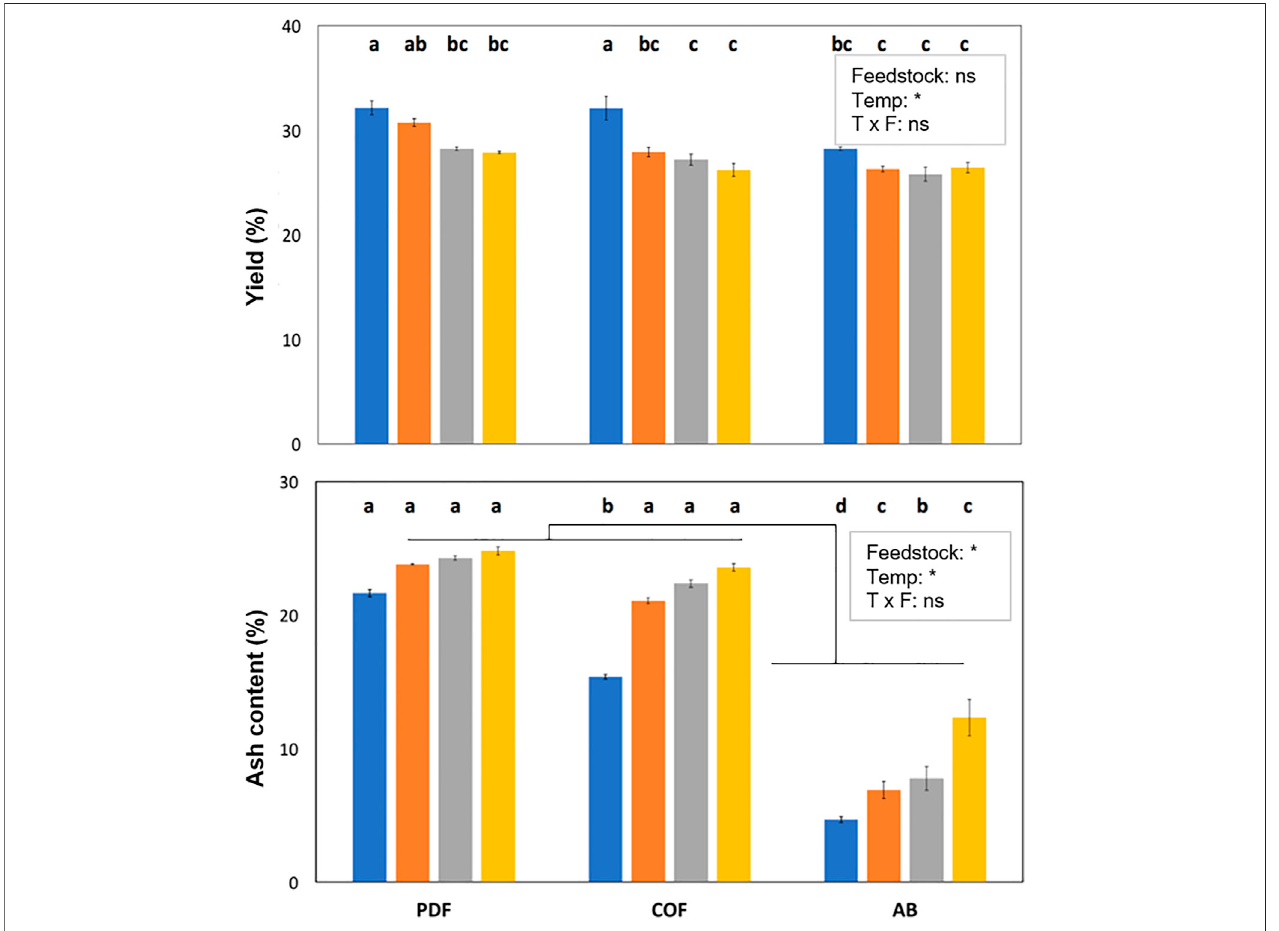
FIGURE4| Yield(%)andashcontent(%)forthe3biochars (PDF,COF, andAB)produced at4temperatures(350,450,500and 550 ° C).Barswithdifferentletters indicate signi fi cant differences p < 0.05, n = 3 (two-way ANOVA, TukeyHSD). PDF: palm date fi ber, COF: coffee bean husks, AB: waste wood mix.